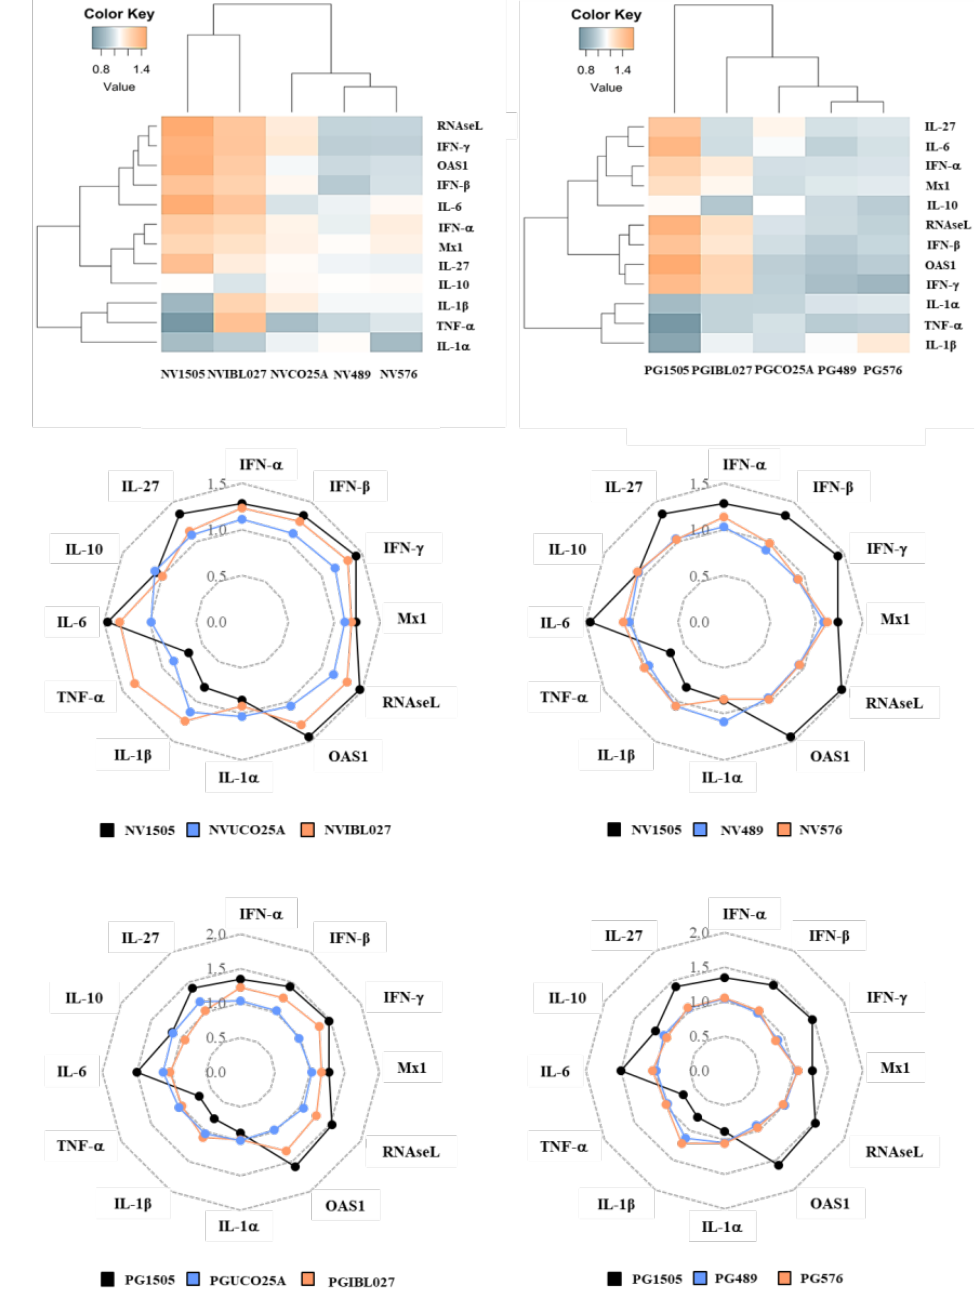
Figure 4. Effect of non-viable (NV) L. rhamnosus CRL1505, CRL498, CRL576, UCO25A and IBL027 and their peptidoglycans (PGs) on alveolar macrophage cytokines and antiviral factor profiles in response to respiratory syncytial virus (RSV) challenge. Infant mice were nasally primed with NVs or PGs for two consecutive days. Alveolar macrophages were isolated from infant mice on the third day and challenged in vitro with RSV. The expression of IFN- α , IFN- β , IFN- γ , Mx1 , RNAseL , OAS1 , IL-1 α , IL-1 β , TNF-1 α , IL-6 , IL-10 and IL-27 genes were evaluated in alveolar macrophages by quantitative PCR (qPCR) after 12 h. The results represent data from three independent experiments. The multiple comparisons of the magnitude of the fold expression changes with respect to the control are shown for the NV1505 vs. NVUCO25A vs. NVIBL027, NV1505 vs. NV489 vs. NV576, PG1505 vs. PGUCO25A vs. PGIBL027 and PG1505 vs. PG489 vs. PG576 groups.